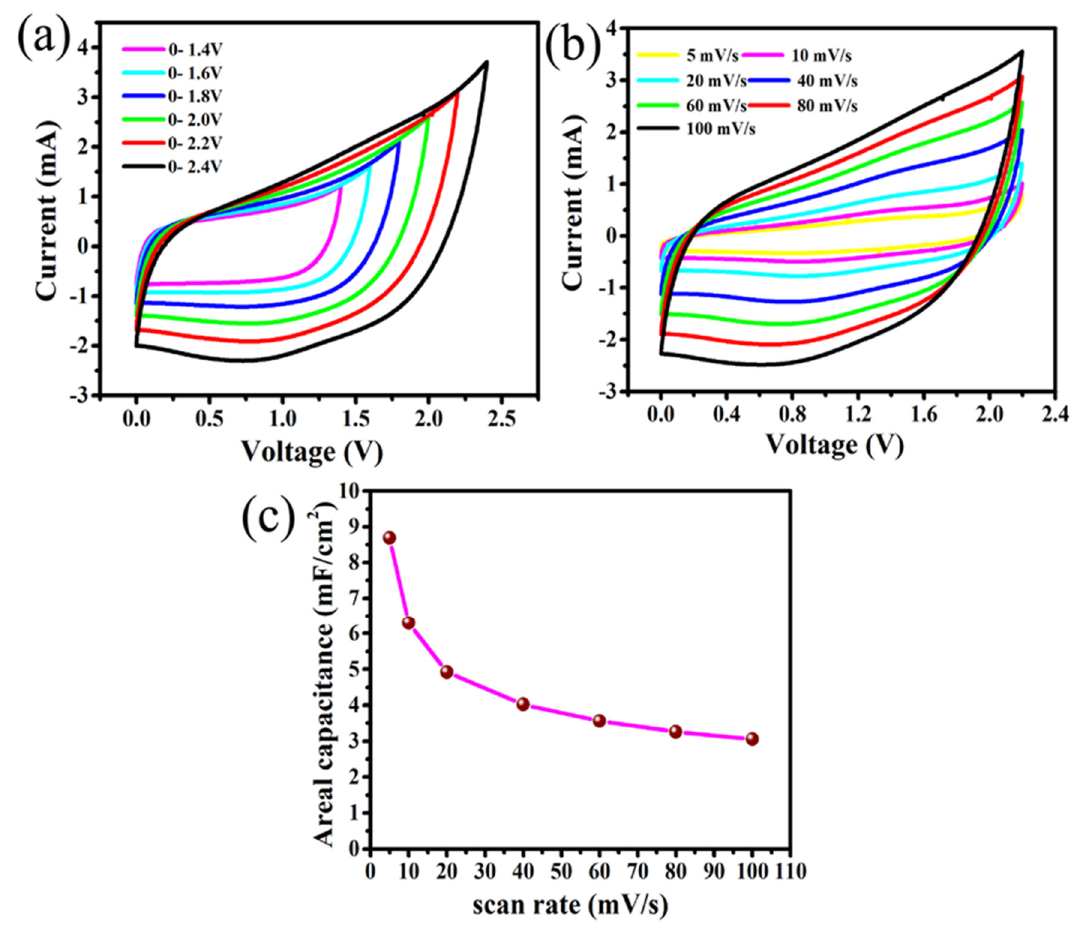
Figure 2. ( a ) Cyclic-voltammetry (CV) at different potential windows, ( b ) CV at different scan rate and ( c ) areal capacitance vs. scan rate of flexible supercapacitor (FSC) based on Mn/MnO x @Graphite-foil electrodes and polymer gel electrolyte.